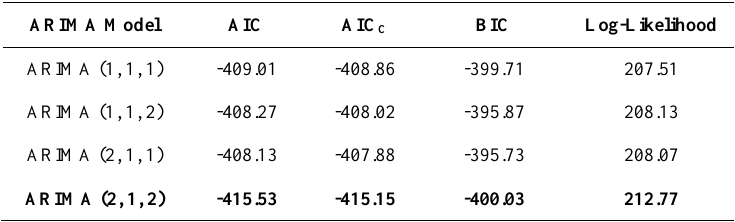
Table 3. Akaike Information Criterion (AIC)